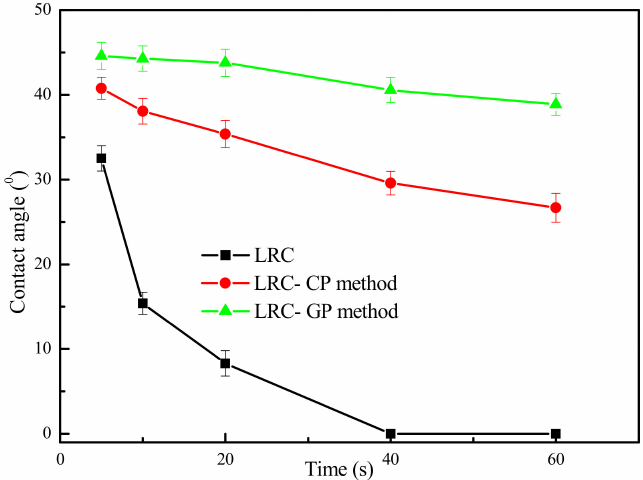
Figure 3. Contact angle results of water on LRC surface in the presence of gaseous pretreatment (GP) and conventional pretreatment (CP) method (Dodecane dosage 6 kg / t) (The data points represent the mean values (n = 3) ± standard